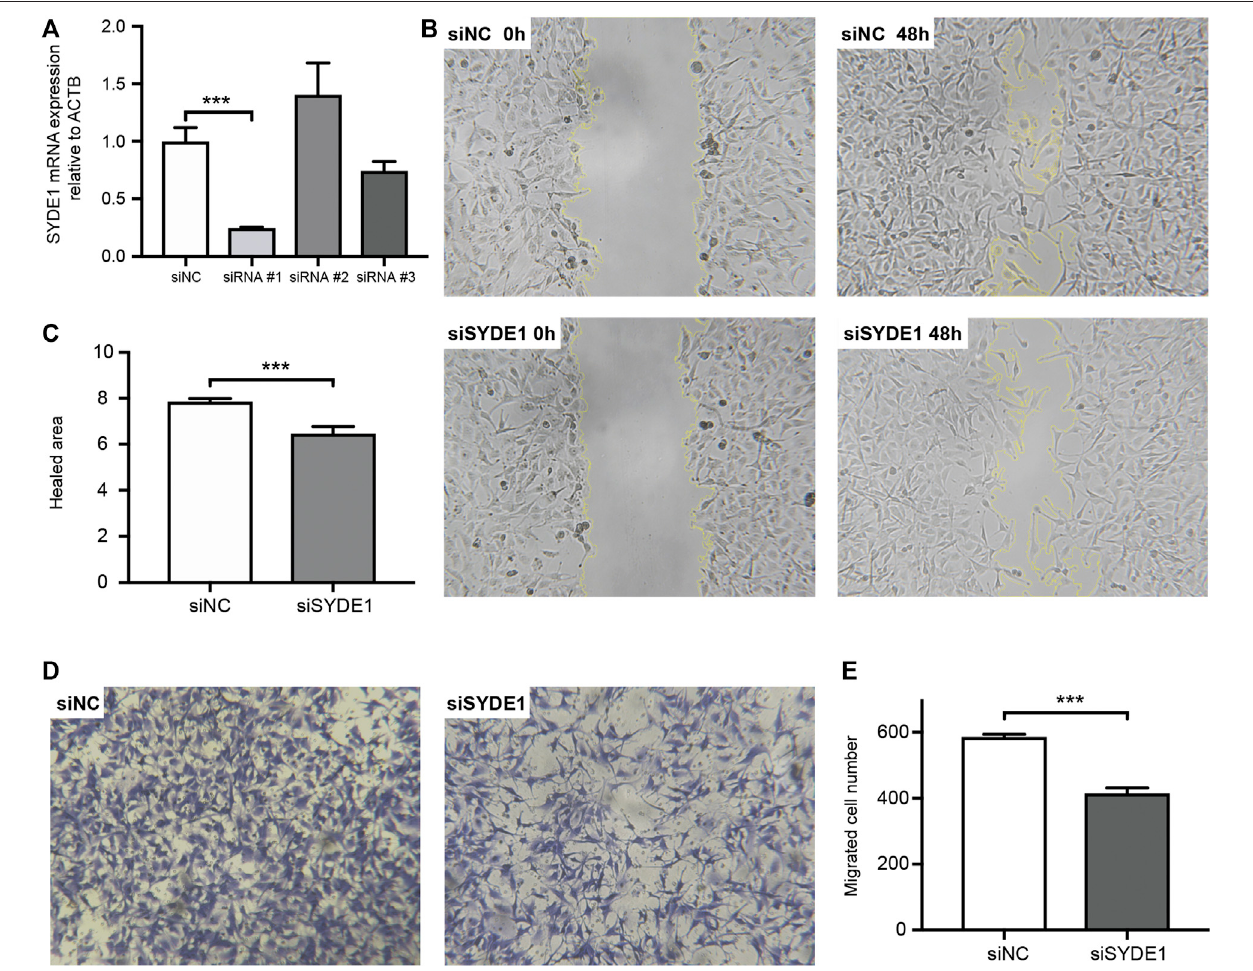
FIGURE8| Wound scratch assayand transwellassay. (A) qPCR results indicate thatknockdown of SYDE1 with siSYDE1#1achieves thehighest ef fi ciency.Data are presented as mean ± SD, n (cid:1) 3 per group, ***, p.value < 0.001 for siSYDE1 #1 group versus control group. (B) Representative images of A172 migration in the siNC andsiSYDE1groupsat0and48 hinthescratchassay. (C) Bargraphillustratingthenumberofcellsperhigh fi eld.Dataarepresentedasmean ± SD,n (cid:1) 3pergroup,***, p.value < 0.001 for siSYDE1group versus control group. (D) Representative images of invasive cells in the lower chamber stained with crystal violet in the siNC and siSYDE1 groups in the transwell assay. (E) Bar graph illustrating the percentage of the scratched area covered. Data are presented as mean ± SD, n (cid:1) 3 per group, ***, p.value < 0.001 for siSYDE1 group versus control group.